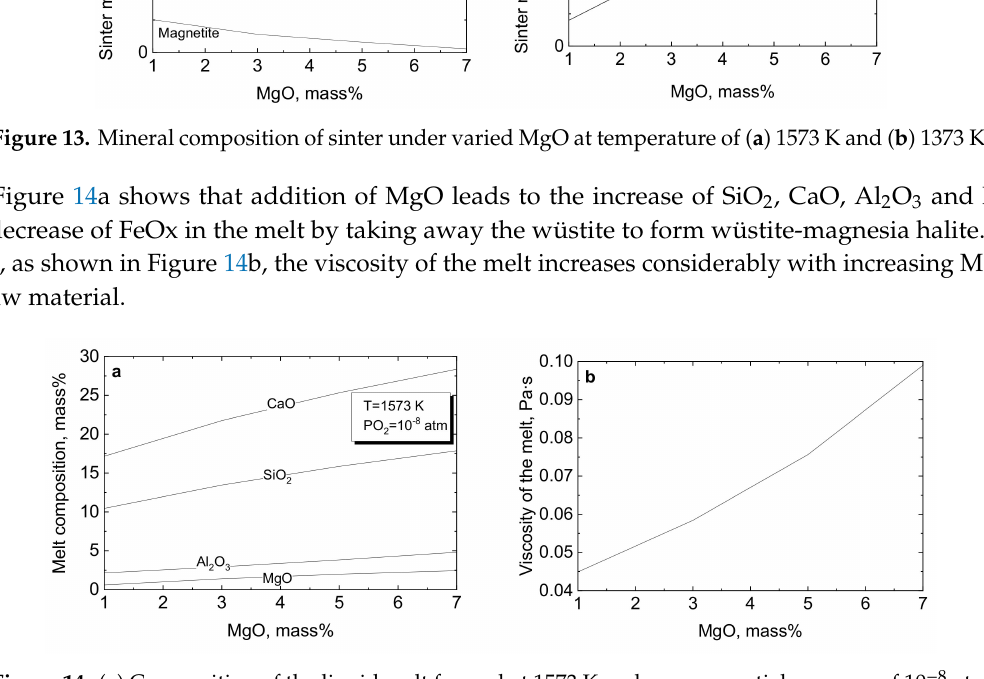
Figure 14. ( a ) Composition of the liquid melt formed at 1573 K and oxygen partial pressure of 10 − 8 atm and ( b ) the viscosity of the melt under various MgO